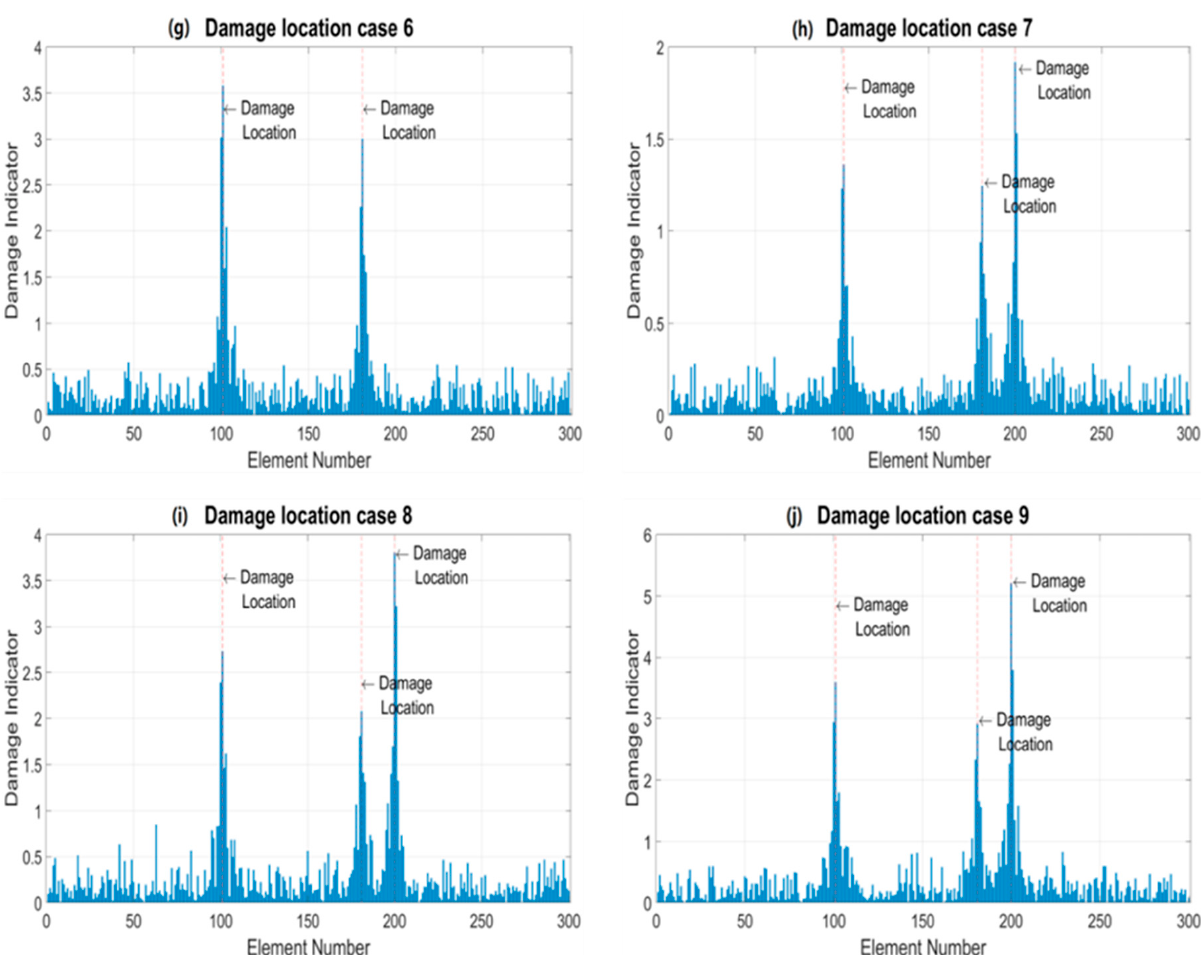
Figure 12. Damage location results for a moving load with 12% white noise: ( a ) undamaged case;